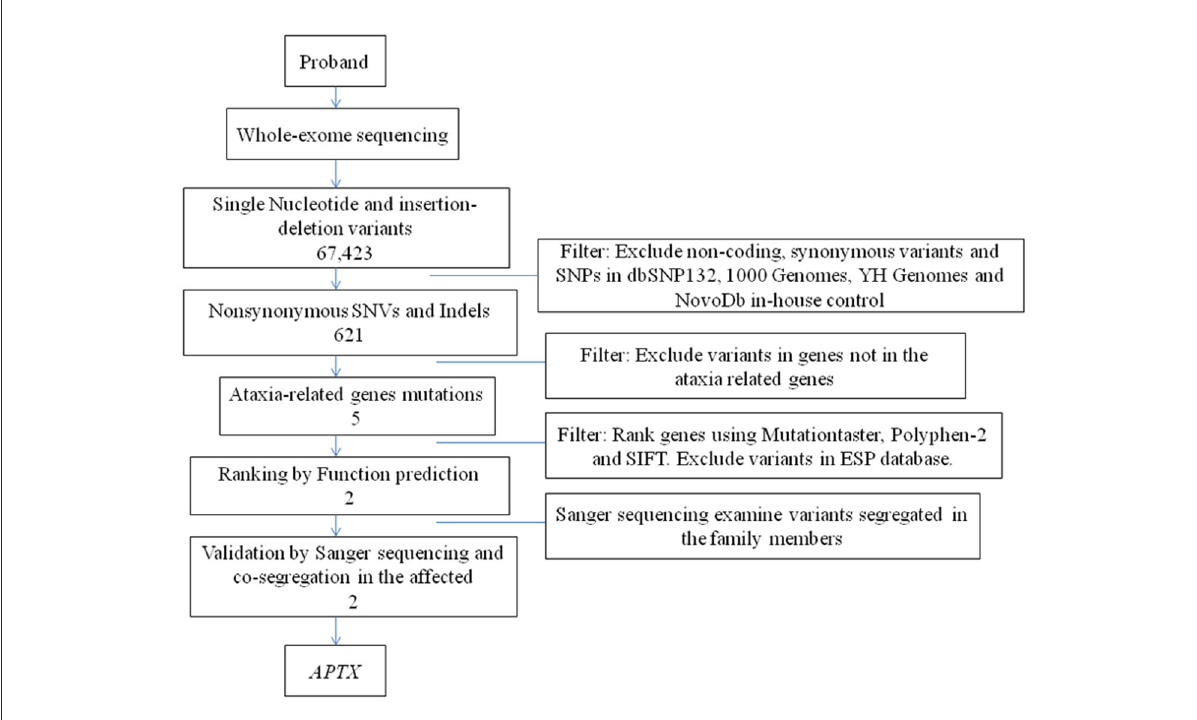
FIGURE2 The strategies of gene date